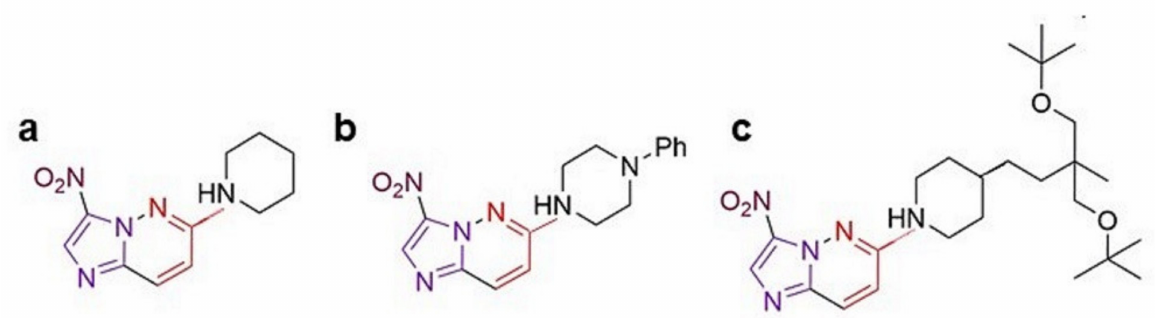
Figure 1. The structure of the compounds used in this study: ( a ) compound 5c, ( b ) compound 5h, and ( c ) compound 5k. Synthesis of these compounds has been described previously